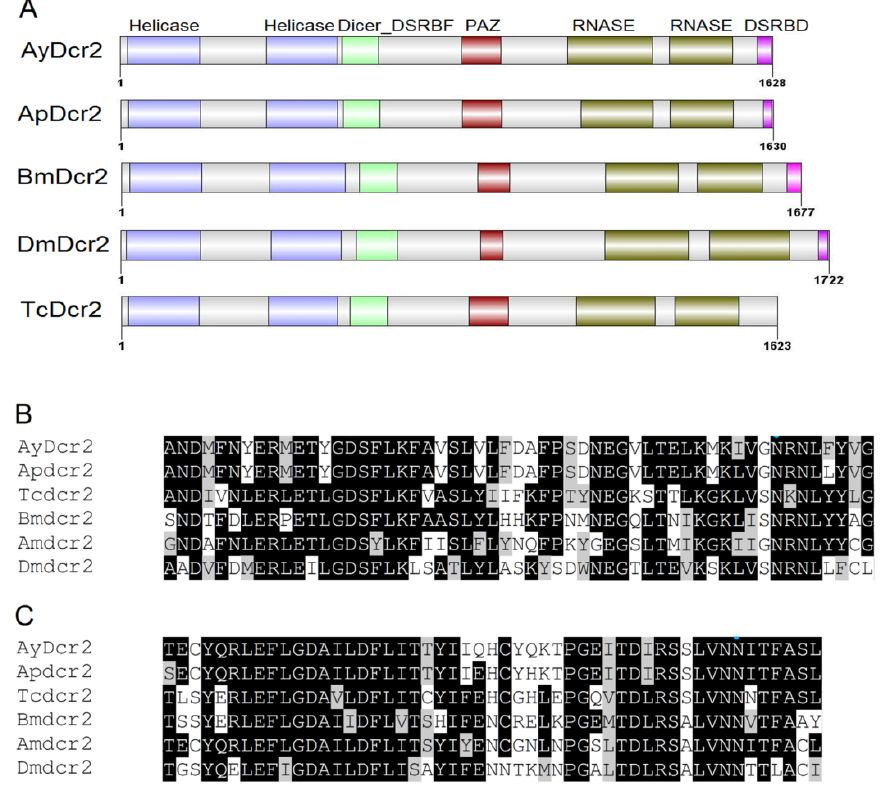
Figure 1. ( A ) Domain architecture of Dicer2 proteins from various insects. ( B ) and ( C ) Partial alignment of RNAse IIIa ( B ) and RNAse IIIb ( C ) domain sequences from insect Dcr2 proteins. The conserved and similar amino acid residues are labeled in black and grey backgrounds respectively. Dicer2 proteins were from Acyrthosiphon pisum (Ap), Aphis glycines (Ay), Apis mellifera (Am), Bombyx mori (Bm), Drosophila melanogaster (Dm), and Tribolium castaneum